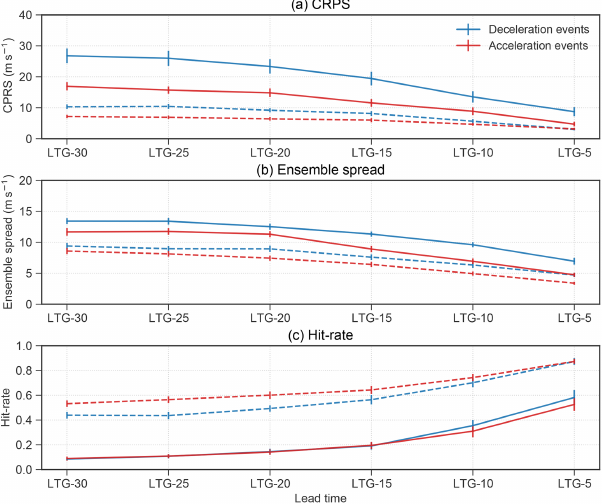
Figure 4. (a) CRPS, (b) ensemble spread and (c) hit rate for ac- celeration events (red) and deceleration events (blue) computed by validating the hindcasts against the reanalysis. Solid lines indicate the mean of the strong magnitude events at different LTGs, and the dotted lines indicate weak magnitude events. The vertical bars indi- cate the standard errors for each